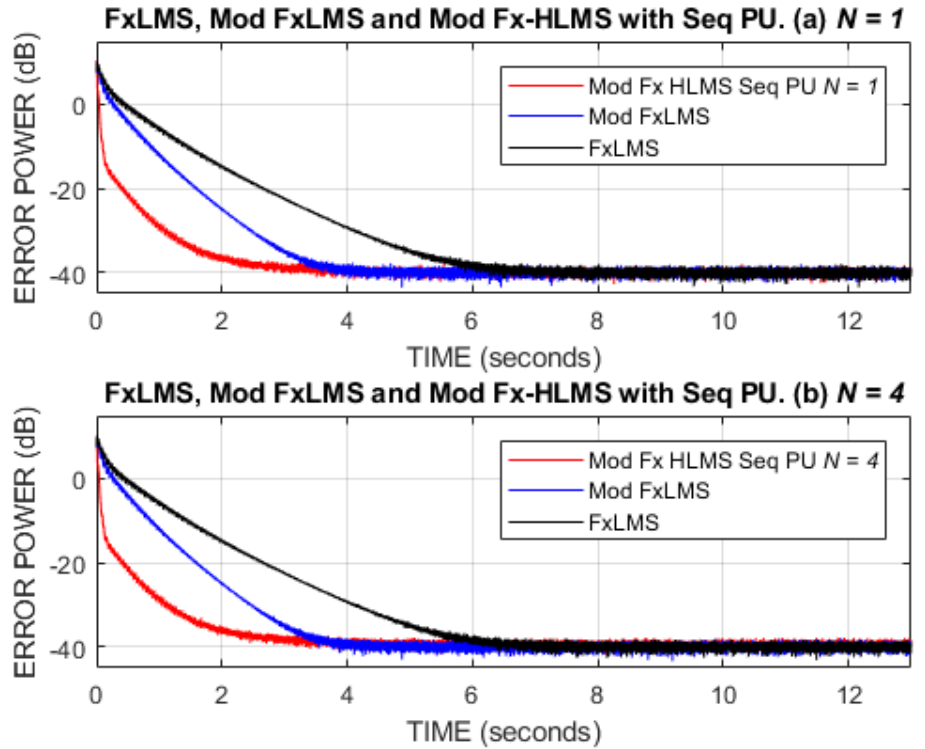
Figure 7. Theoretically predicted step-size gain of the G µ —Mod Fx H Seq PU LMS over the frequency band of interest— from 0 to 800 Hz—for N = 2, 3, and 4. L = 625 taps are organized in 25 subfilters of β = 25 weights.